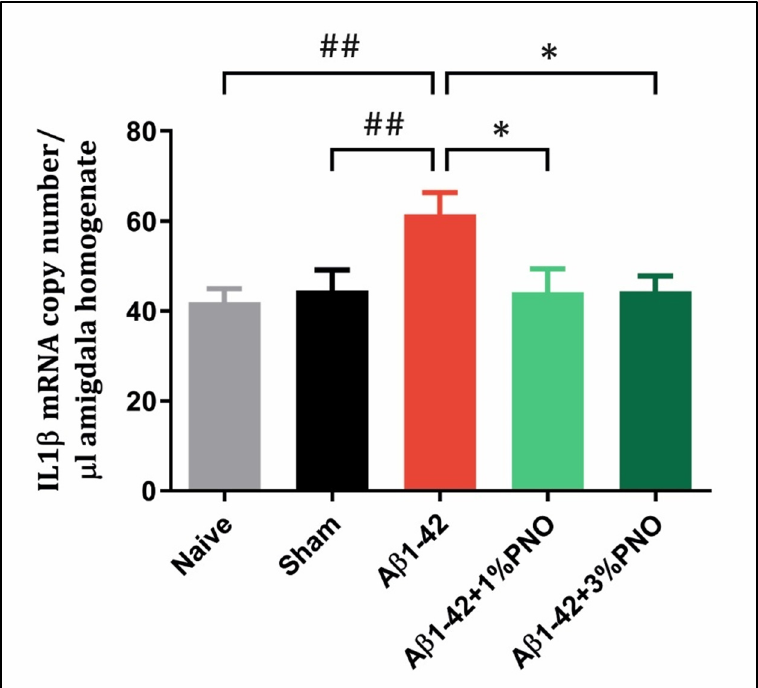
Figure 5. Effects of the inhaled Pinus halepensis essential oil (PNO, 1%, and 3%) on the IL-1 β mRNA copy number determined in the rat amygdala homogenates of the A β 1-42-treated rats. Values are means ± S.E.M. ( n = 5). A β 1-42 vs. Naive: ## p = 0.0037; A β 1-42 vs. sham: ## p = 0.0088; A β 1-42 vs. A β 1-42 + 1% PNO: * p = 0.0109 and A β 1-42 vs. A β 1-42 + 3% PNO: * p = 0.0204.